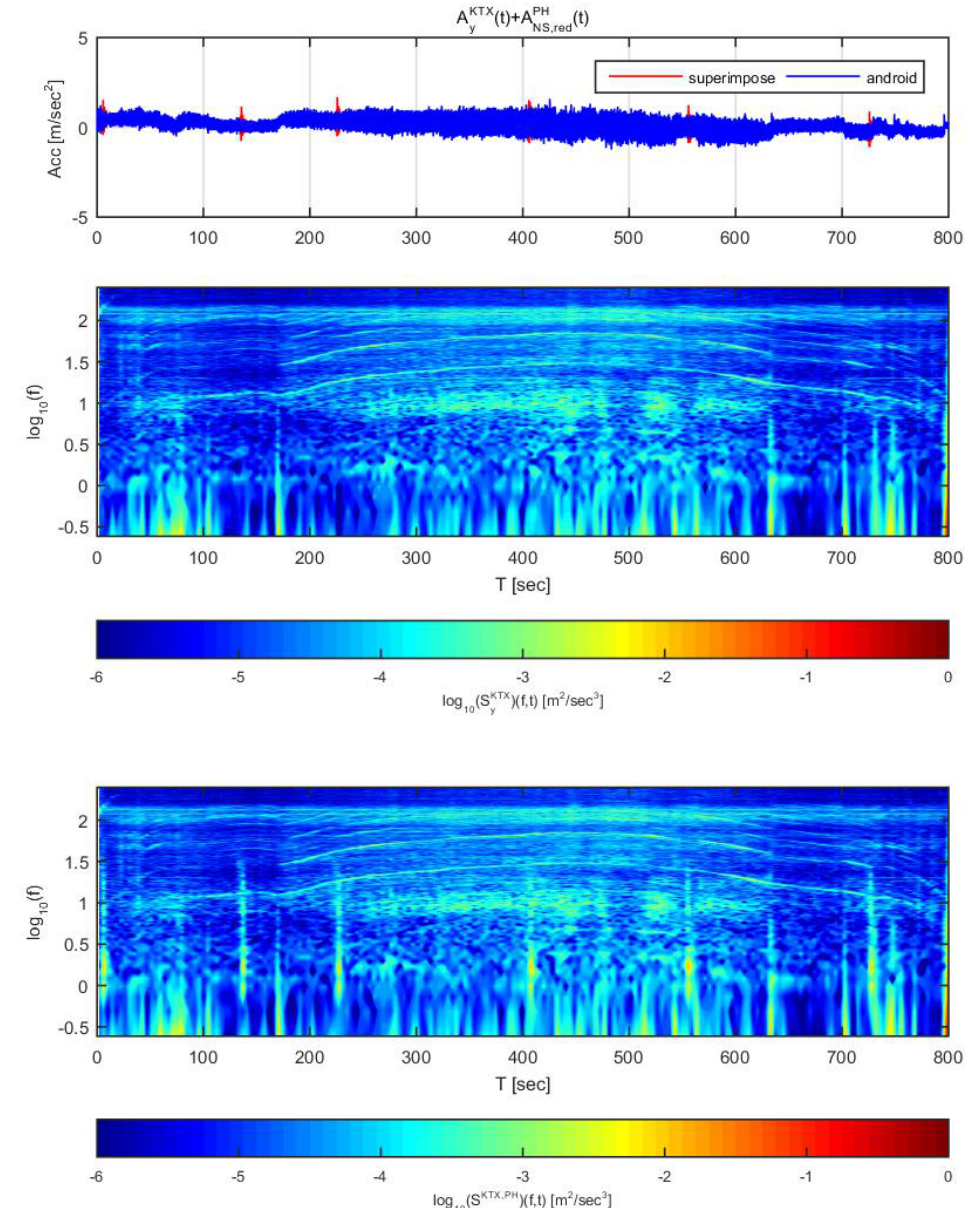
Figure 16. Combination of Korea Train Express (KTX) x-direction data and Pohang earthquake north-south direction data (adjusted to 1 m / s 2 ).